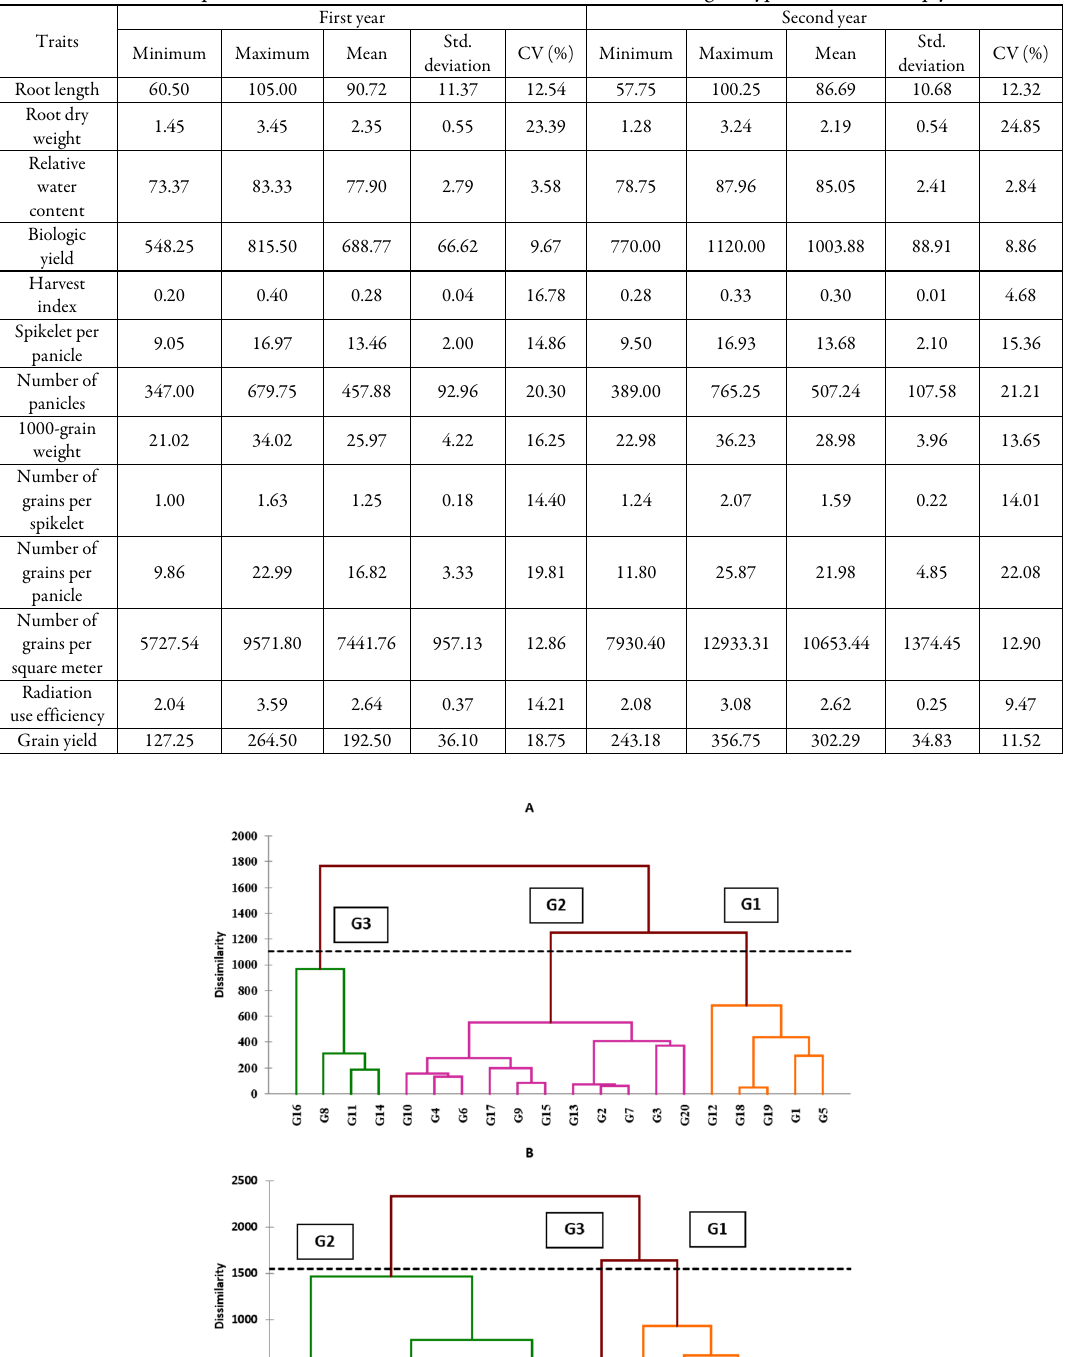
Table 4. Descriptive statistics related to different studied traits in wheat genotypes under two crop year